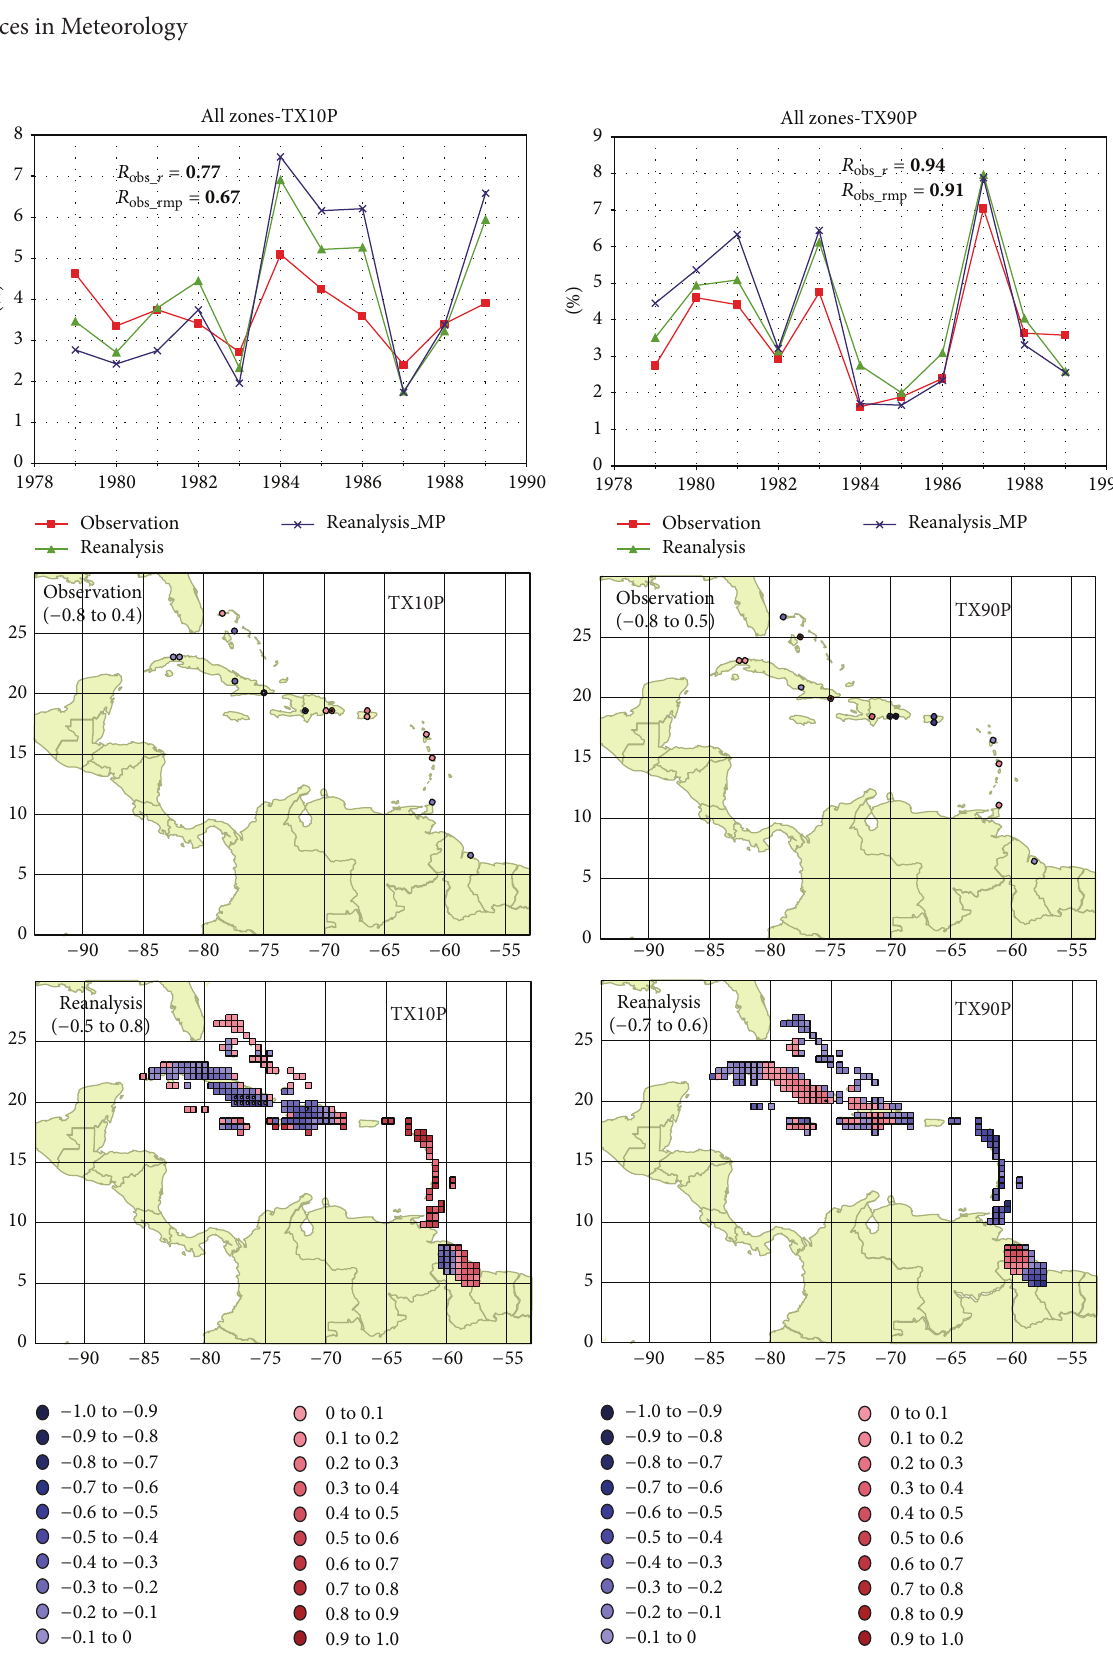
Figure 5: The same as Figure 4 but for cool days (TX10P) and warm days (TX90P). Statistically significant trends are indicated with white